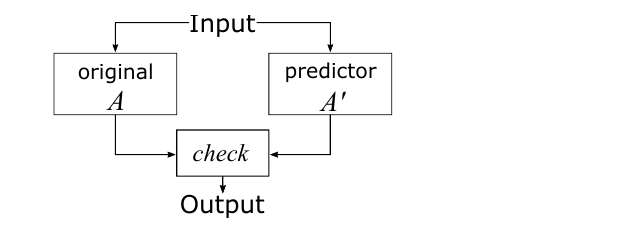
Figure 1: Overview of CED by means of a predictor A 0